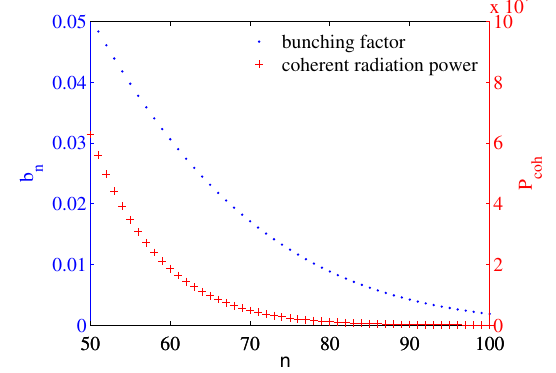
FIG. 2. The bunching factor (blue dot) and coherent radiation power (red cross) of the CHG as a function of the harmonic number.